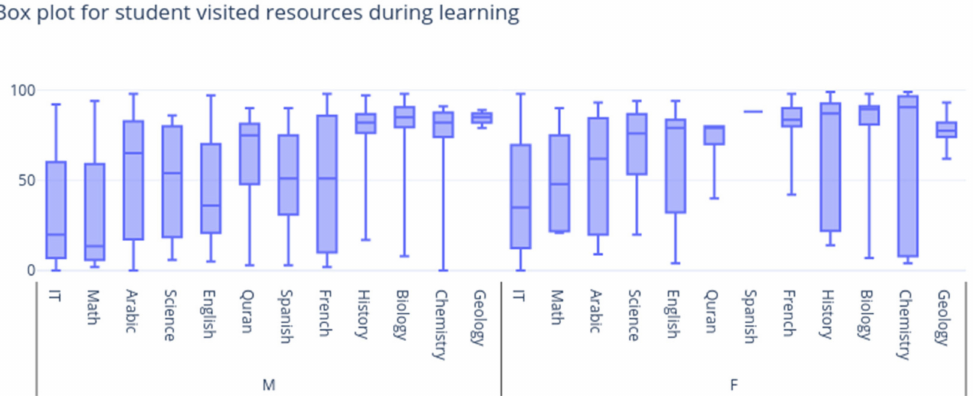
Figure 4. Exploratory data analysis for students’ engagement in e-learning based on gender and the topic